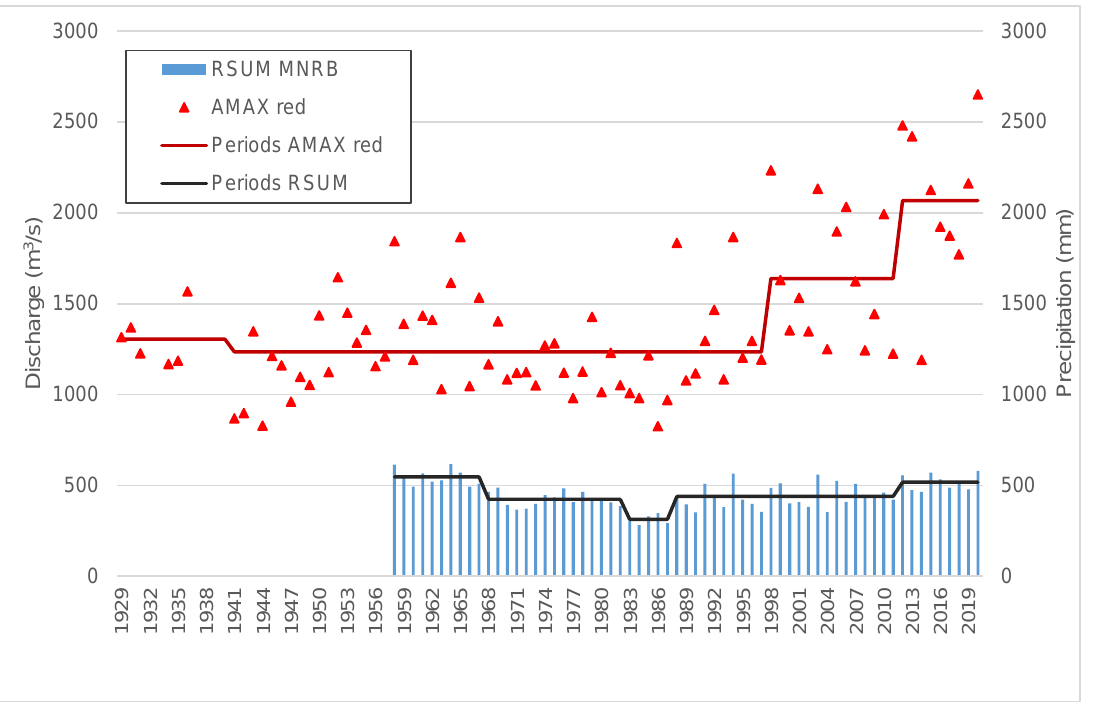
Figure 13. Red AMAX in Niamey and annual precipitation (RSUM) over the MNRB with the average of the periods (Hubert segmentation with Sheffé 1%. Results of the different tests are provided in the Supplementary materials).